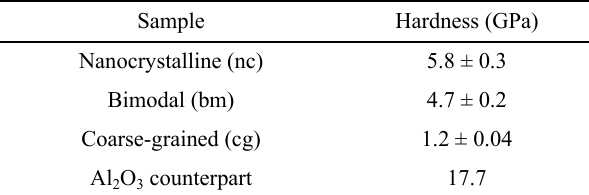
Table 2 Hardness values of the evaluated microstructures.